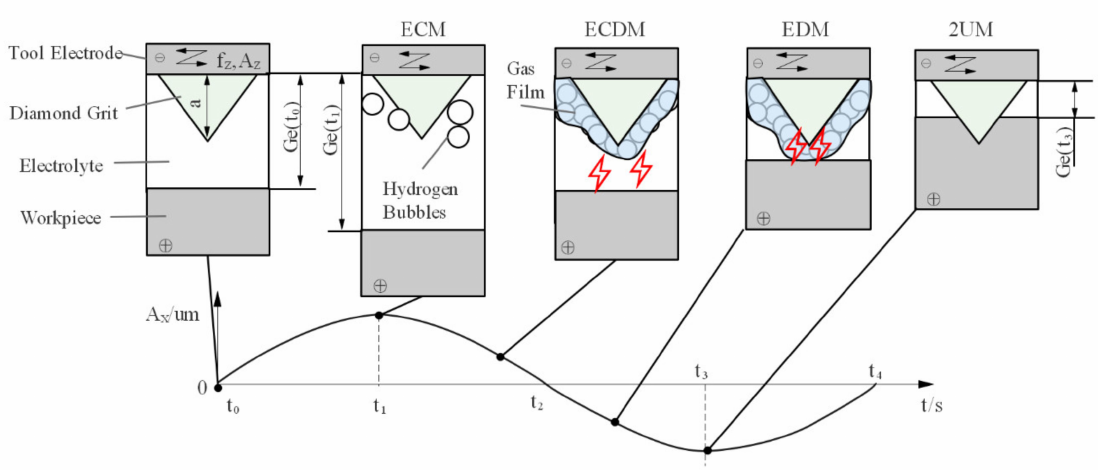
Figure 2. Schematic diagram of the 2UE/DM